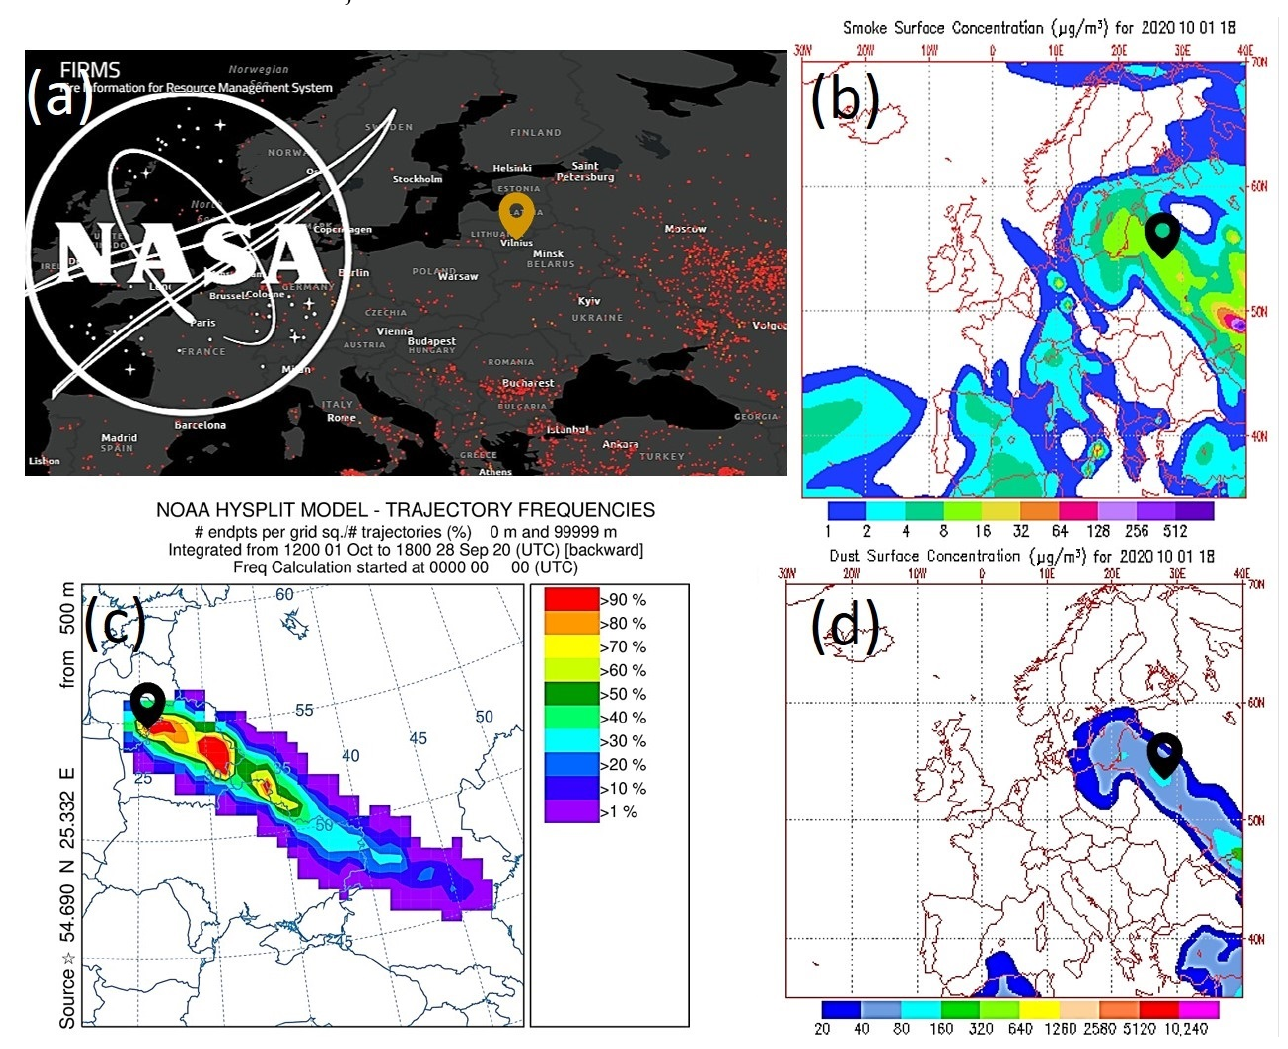
Figure 2. A Fire Information for Resource Management System (FIRMS) fire maps ( a ), air mass backward trajectory ( c ) and aerosol satellite measurements of smoke ( b ) and dust ( d ) over Europe. In each graph a pin shows location of Vilnius.